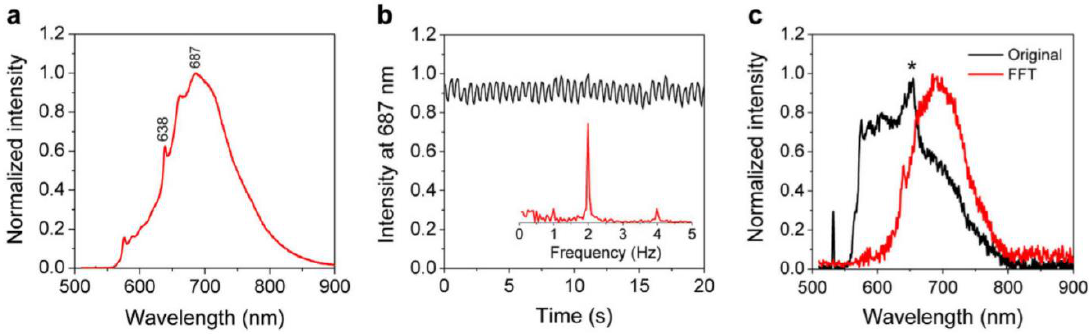
Figure 12. ( a ) Fluorescence spectrum of NDs in water under 532 nm Continuous-Wave (CW)-laser pumping. ( b ) Temporal evolution of the fluorescence intensity at 687 nm under 2 Hz magnetic modulation. The inset shows Fourier transformed frequency spectrum. ( c ) Normalized fluorescence spectrum of NDs in water (black) and its Fast Fourier Transform (FFT) spectrum (red) after demodulation (NDs concentration in water 0.1 μg mL −1 ). The asterisk indicates Raman peaks of water. Reproduced with permission from [85], Springer, 2017.